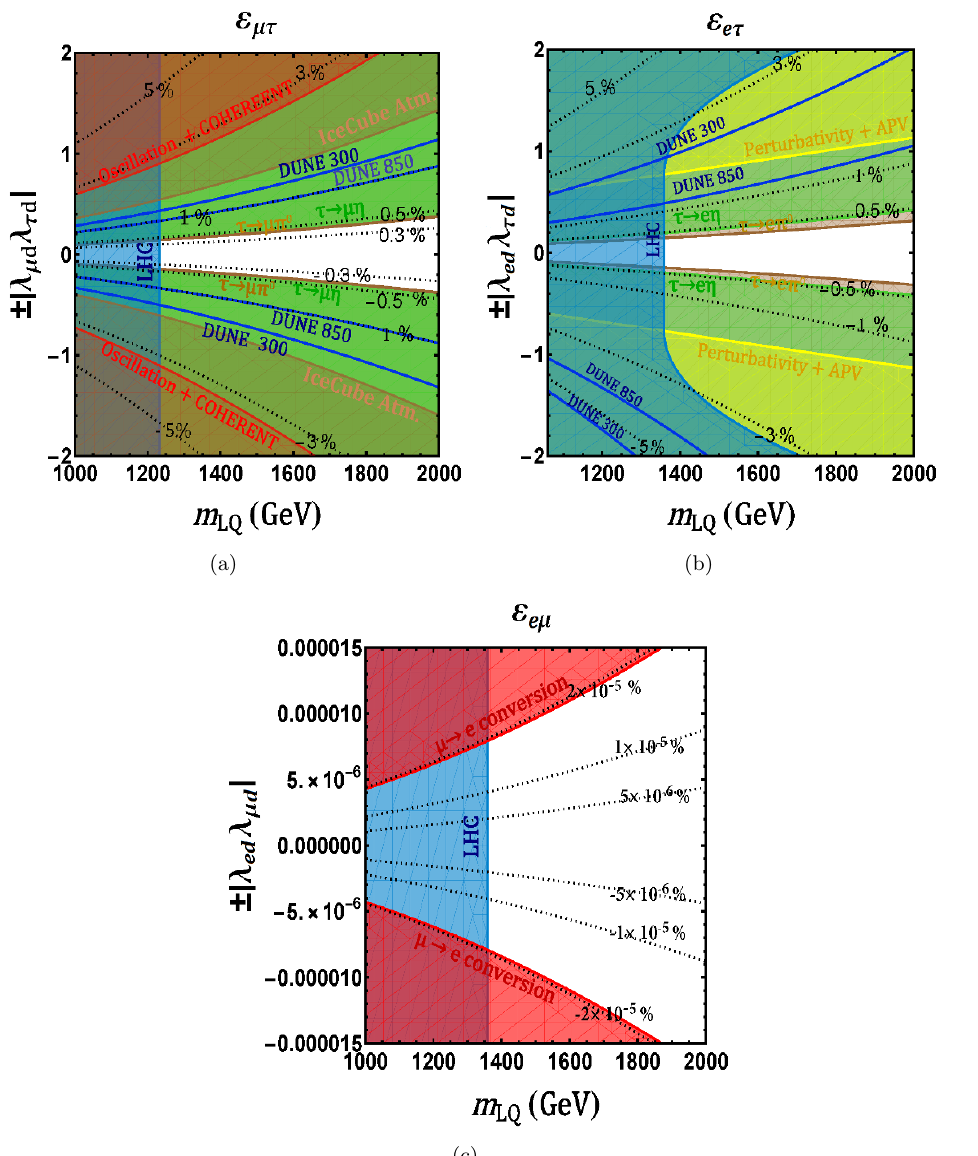
Figure 32 . Predictions for o(cid:11)-diagonal NSI ( " e(cid:22) ; " (cid:22)(cid:28) ; " e(cid:28) ) induced by the doublet LQ in the one-loop LQ model are shown by black dotted contours. Color-shaded regions are excluded by various theoretical and experimental constraints. Blue-shaded area is excluded by LHC LQ searches (cf. (cid:12)gure 29). In (a) and (b), the brown and green-shaded regions are excluded by (cid:28) (cid:28) ‘(cid:17) (with ‘ = e; (cid:22) ) constraints (cf. table 14). In (a), the red-shaded region is excluded by ! the global-(cid:12)t constraint on NSI from neutrino oscillation+COHERENT data [61], and the light brown-shaded region is excluded by IceCube constraint [154]. In (b), the yellow-shaded region is excluded by perturbativity constraint on LQ coupling (cid:21) (cid:11)d [192] combined with APV constraint (cf. eq. (5.18)). In (c), the red-shaded region is excluded by (cid:22) shown in (b) are the future DUNE sensitivity in blue solid lines for both 300 kt.MW.yr and 850 kt.MW.yr [66].